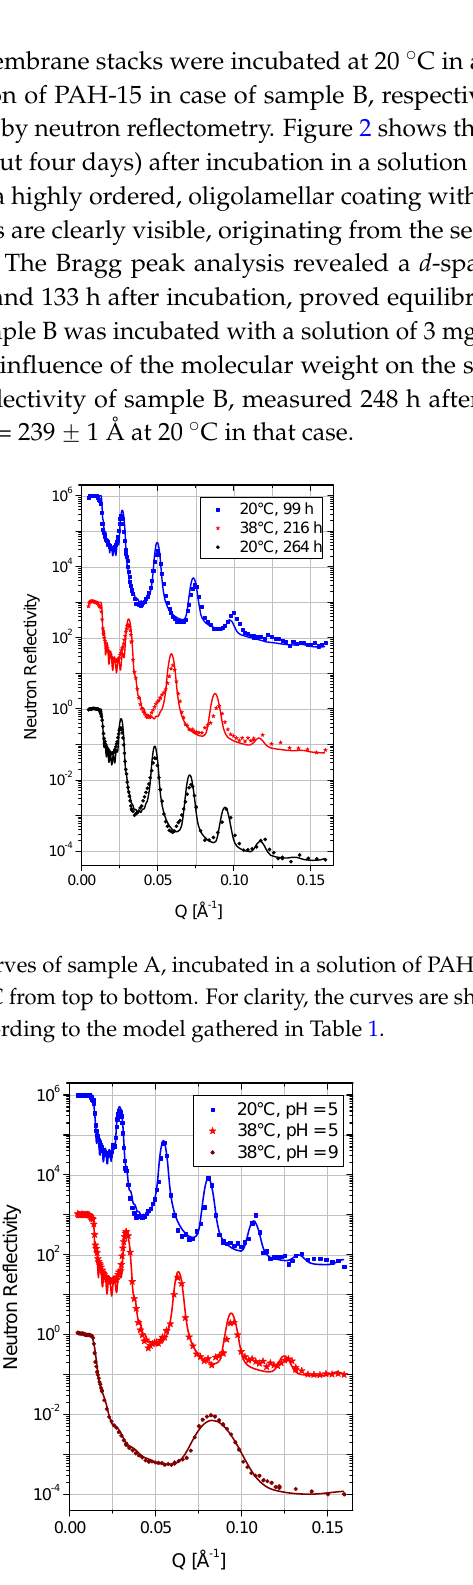
Figure 3. Neutron reflectivity curves of sample B, incubated in a solution of PAH-15 in D 2 O at pH = 5 at 20 °C and 38 °C, and at pH = 9 at 38 °C. For clarity, the curves are shifted vertically. Solid lines are best fits to the data according to the model gathered in Table 2.